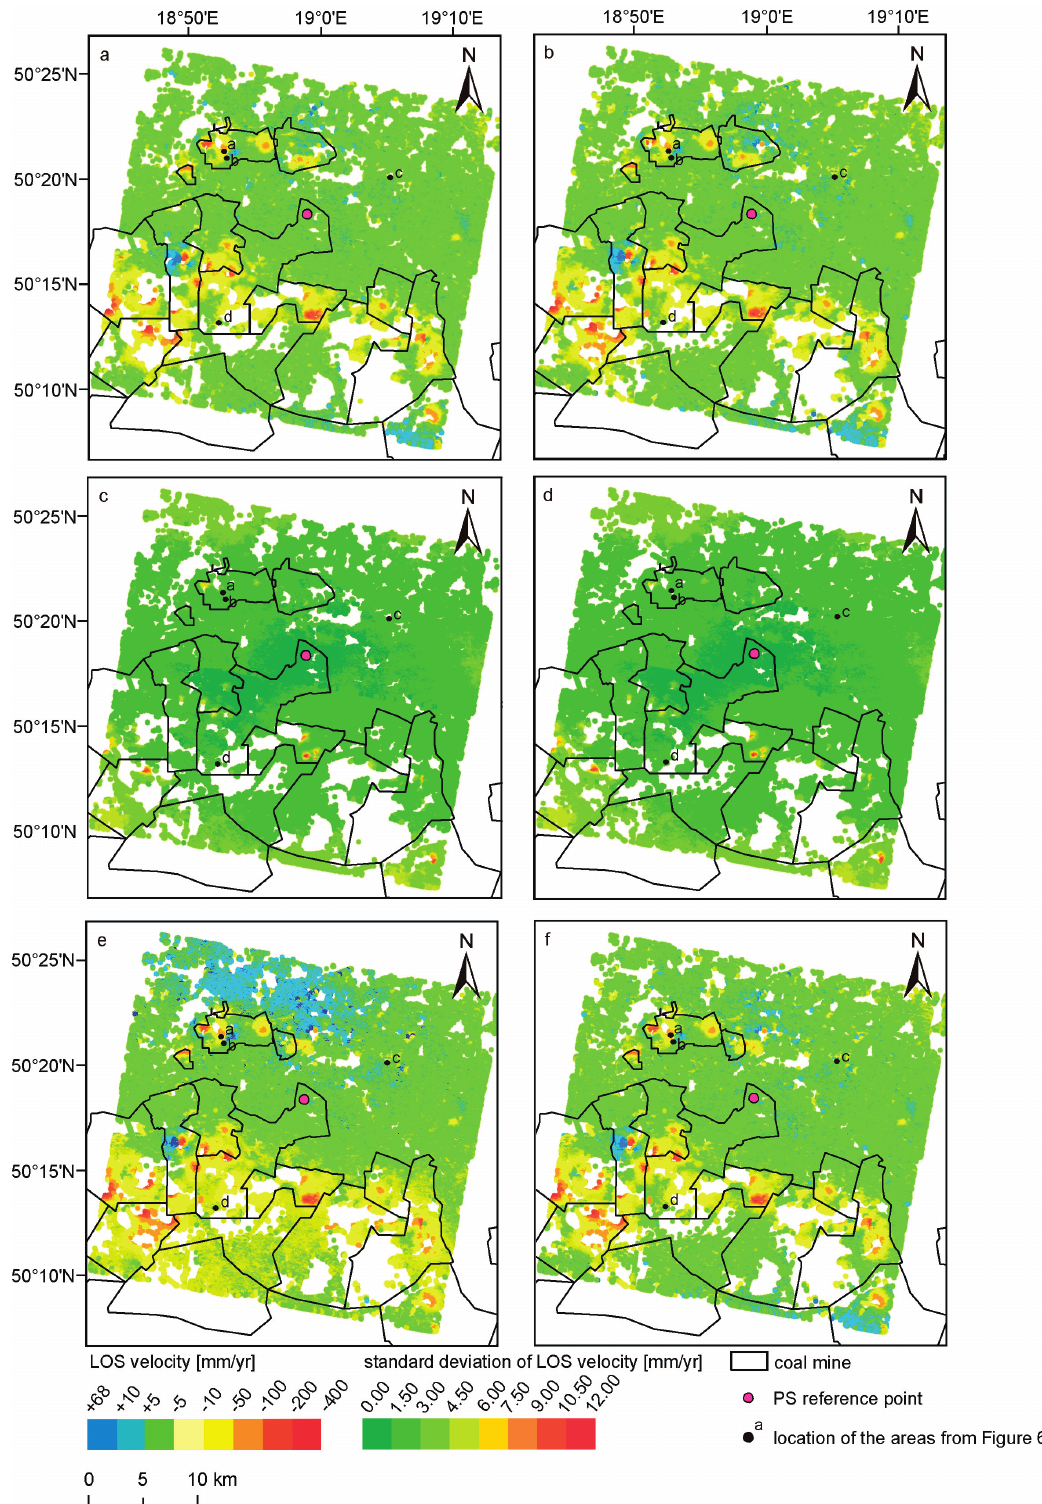
Figure 4. SqueeSAR TM Line of Sight (LOS) velocity in mm per year results displayed in a color scale, where green values are stable, blue uplift, and yellow, orange and red are subsidence. ( a ) LOS velocity of point scatterers (PS); ( b ) LOS velocity of distributed scatterers (DS); ( c ) standard deviation map of the LOS velocity of PS; ( d ) standard deviation map of the LOS velocity of DS; ( e ) dataset before ramp removal; and ( f ) dataset after ramp